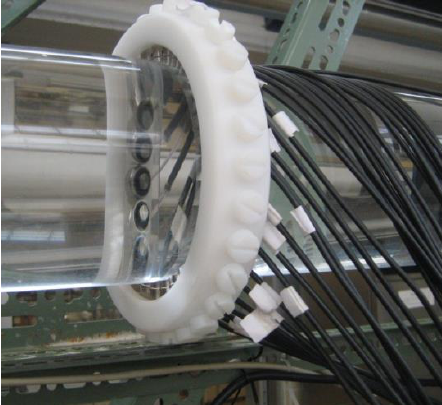
Figure 7. Image of one of the 32 Titanium electrodes test rings.